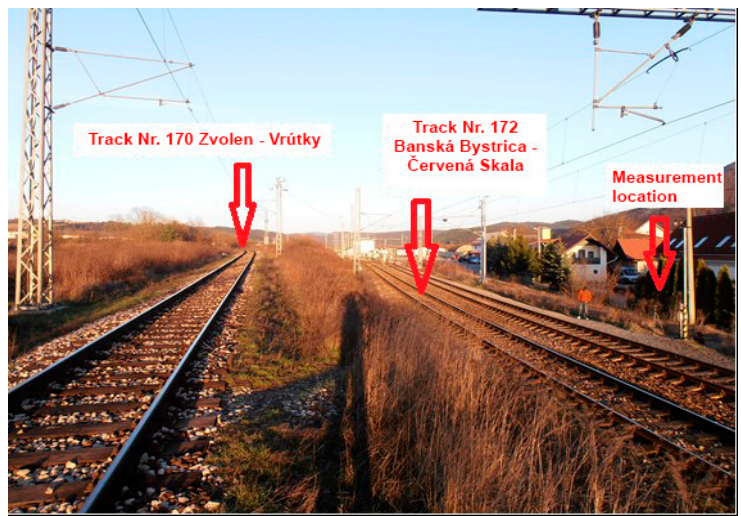
Figure 1. Measurement location “ZV”.